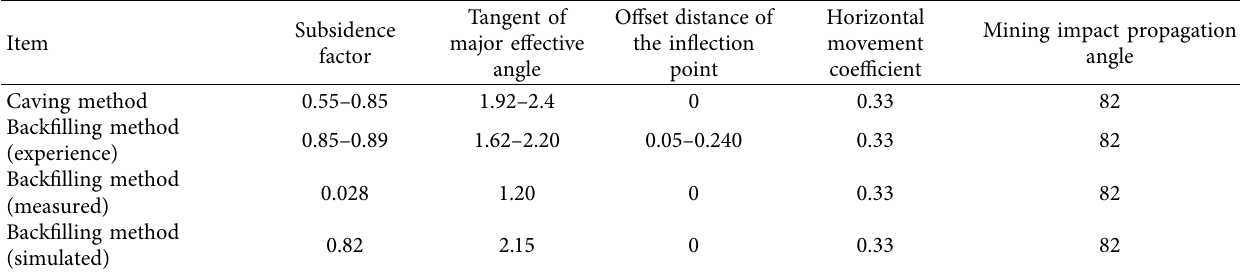
Table 4: Calibration of projected surface parameters for the Tangshan